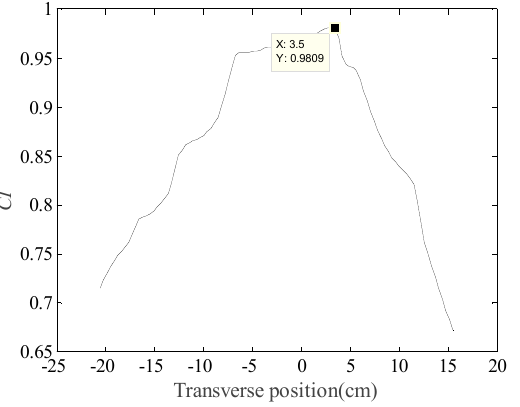
Figure 17. The variation curve of the CI index with the transverse position under case 4.